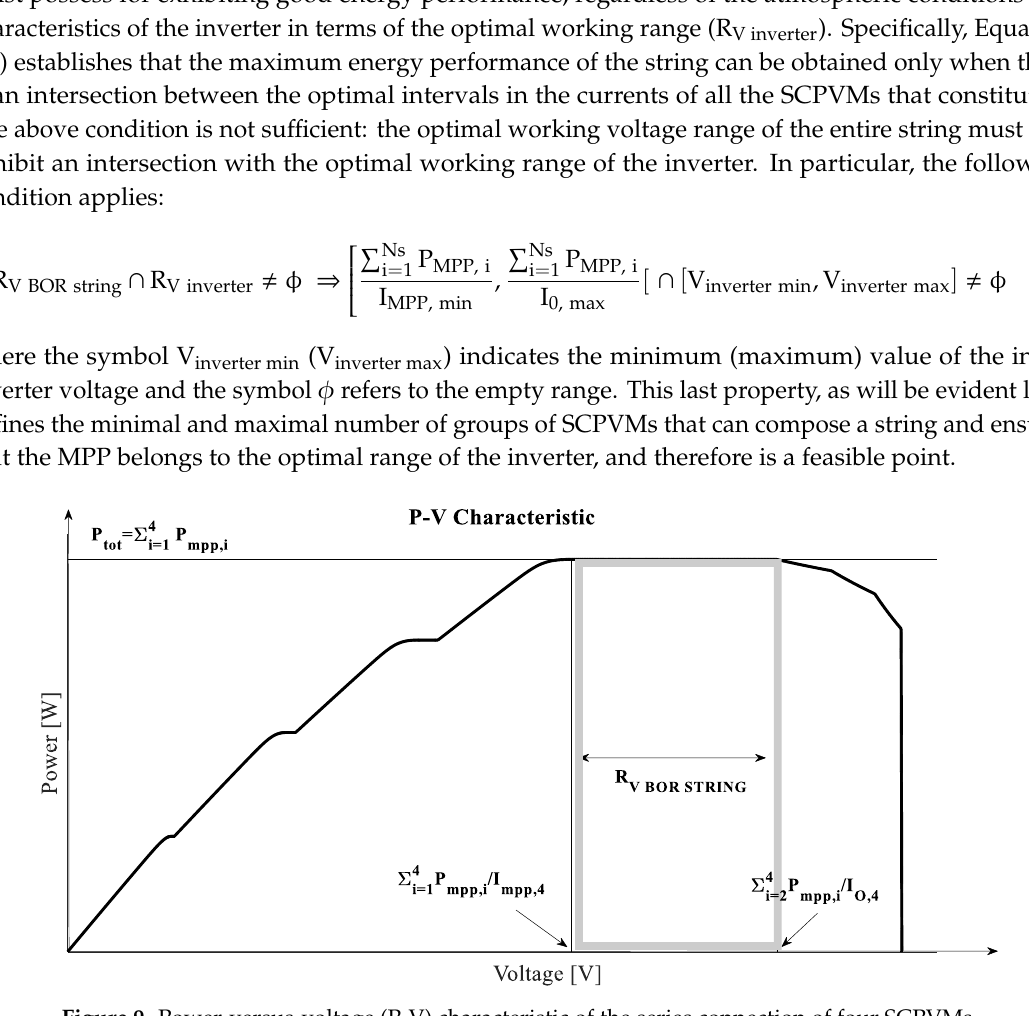
Figure 9. Power-versus-voltage (P-V) characteristic of the series connection of four SCPVMs.